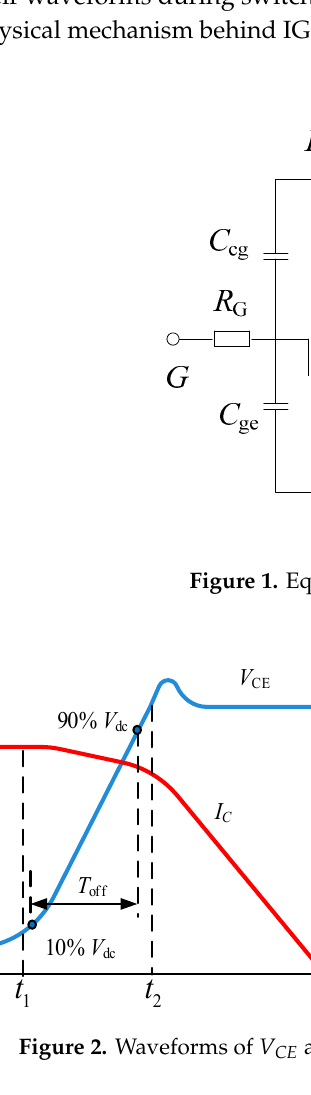
Figure 2. The physical mechanism behind IGBT switching transitions is described as follows: